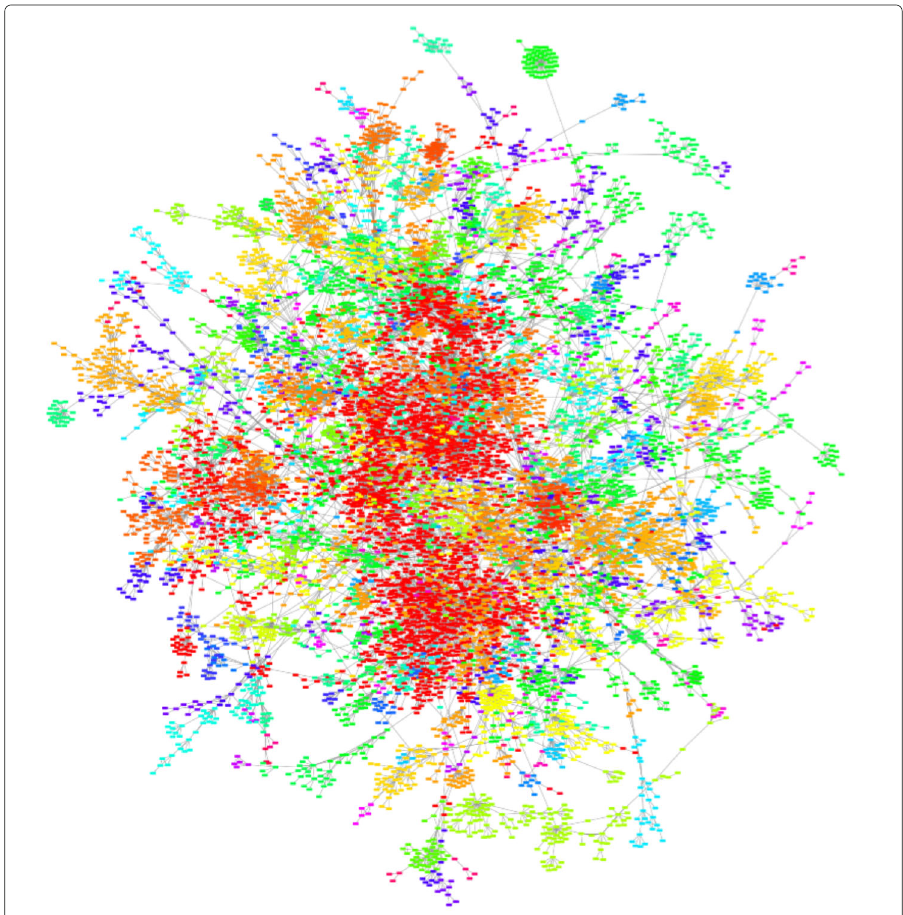
Fig. 1 Representation of the largest connected component of the federal criminal intelligence network consisting of 9887 individuals. The colors are used to represent the different communities to which individuals are assigned according to the Louvain method (Blondel et al. 2008). As the number of modules is relatively large (91), several tones are perceived as the same